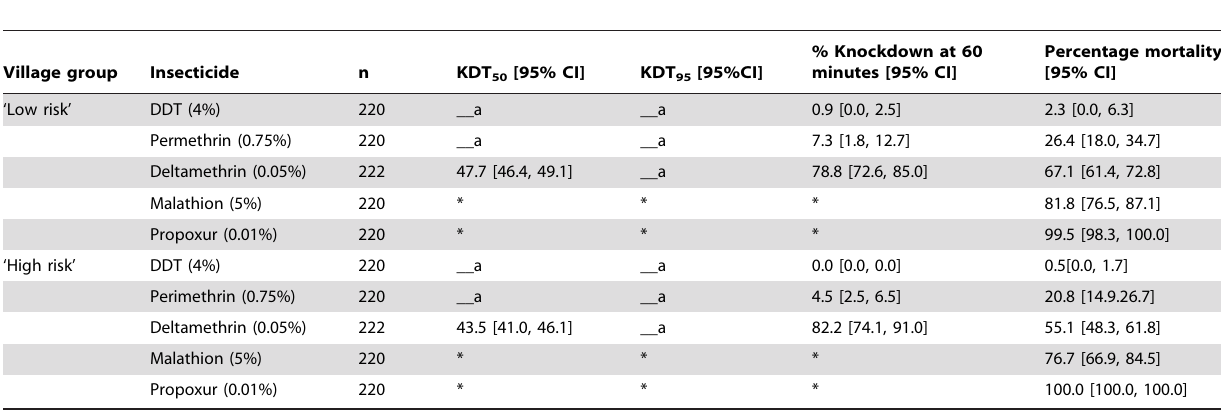
Table 1. Mortality rate and knockdown in field populations of Anopheles arabiensis exposed to discriminating concentrations of 5 insecticides in Gilgel-Gibe dam area, southwestern Ethiopia.